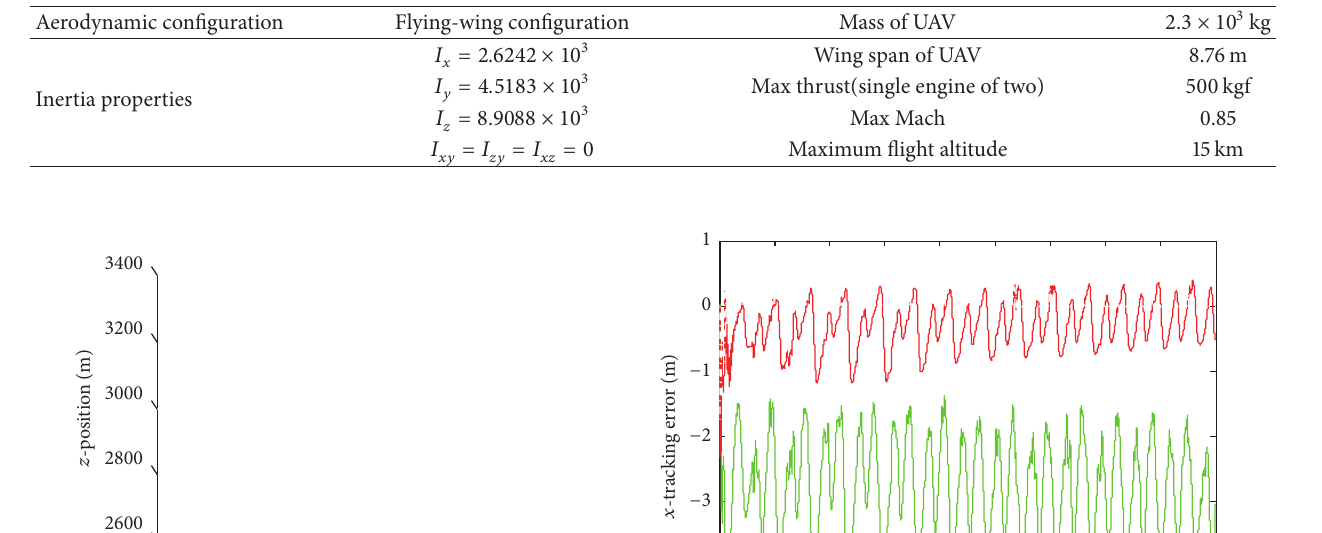
Table 1: Data of the UAV in simulations.